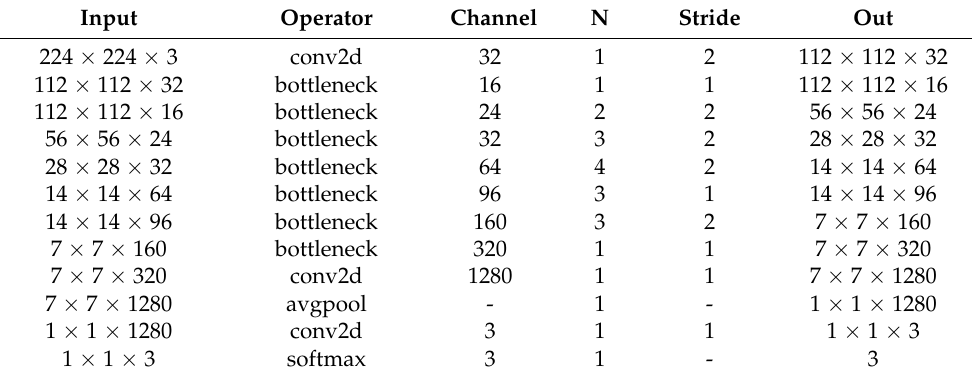
N: represents the number of repetitions of the Operator.